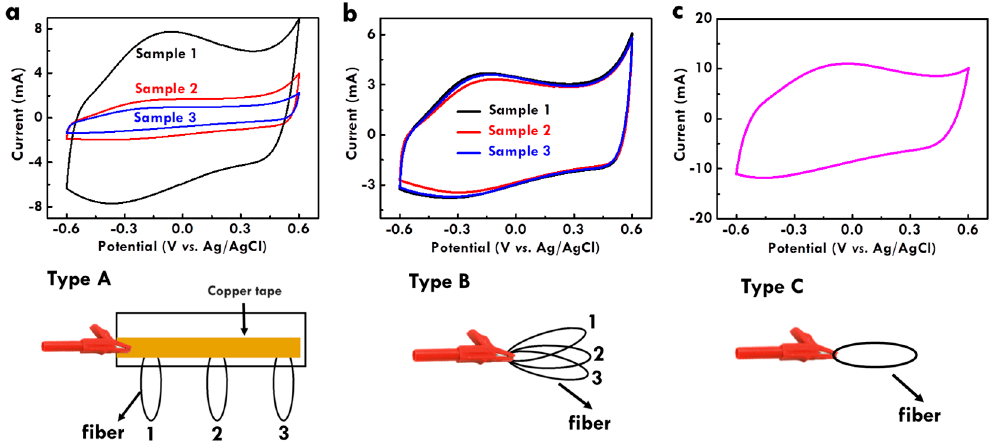
Figure 5. The CV curves for the CF@PPy electrodes prepared using 1 mA and 80 min in the electrolyte of 0.5 M pyrrole and 0.3 M NaClO 4 with the electropolymerization configurations of ( a ) type A, ( b ) type B, and ( c ) type C.